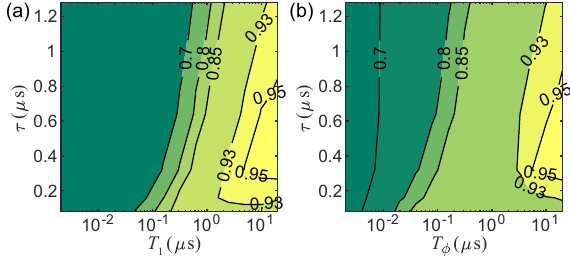
Fig. 3 The error analysis of the average con fi dence. a The simulated average con fi dence as a function of the qubit relaxation time T 1 and the pulse length τ , while the qubit pure dephasing time T ϕ is in fi nite; ( b ) The simulated average con fi dence as a function of T ϕ and τ , while T 1 is in fi nite. npj Quantum Information (2023)